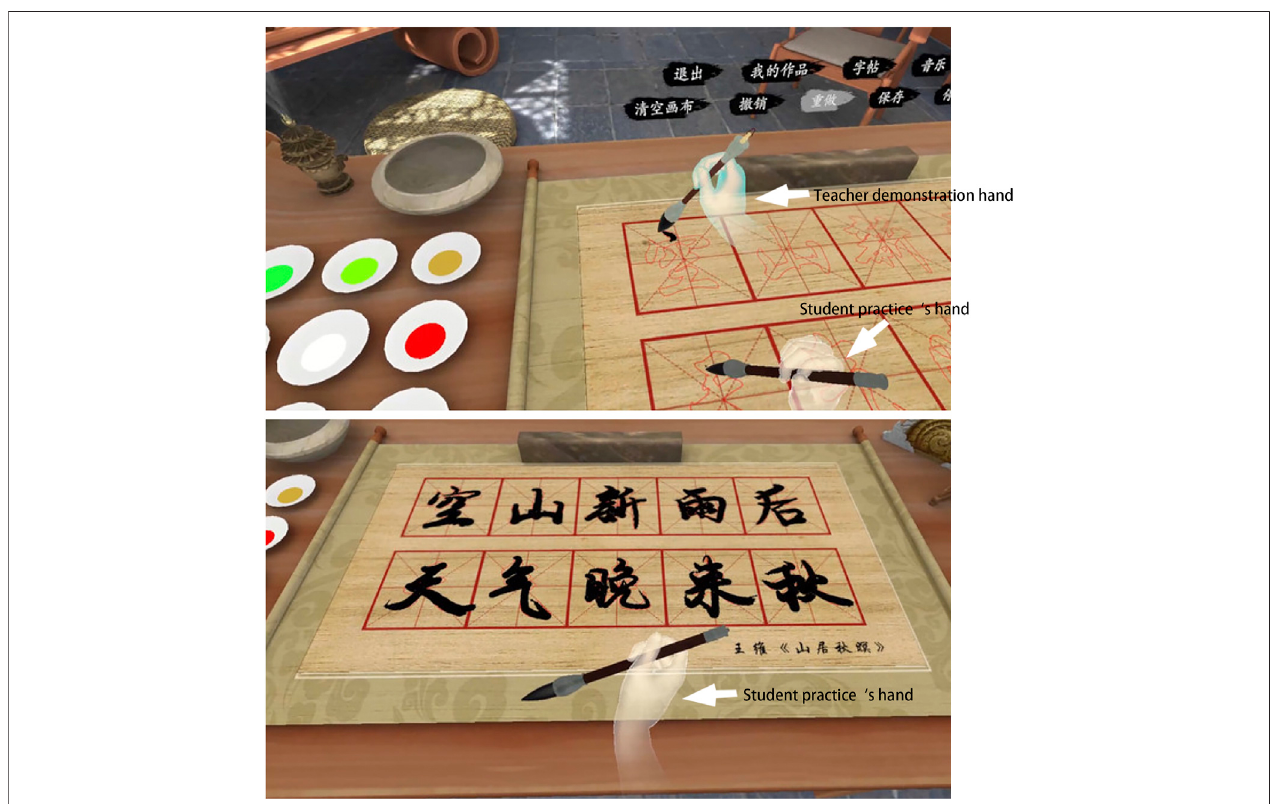
FIGURE 4 | “ You, Calligrapher ” operating